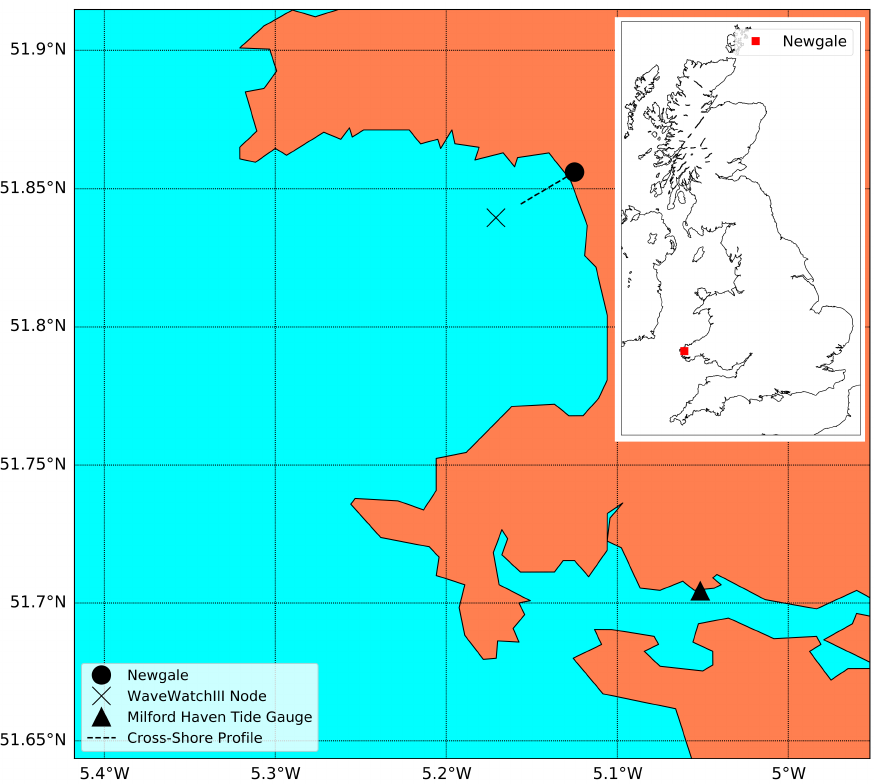
Figure 2. Location of the cross-shore profile, WaveWatchIII node and Milford Haven tide gauge, and the location of Newgale within the U.K.